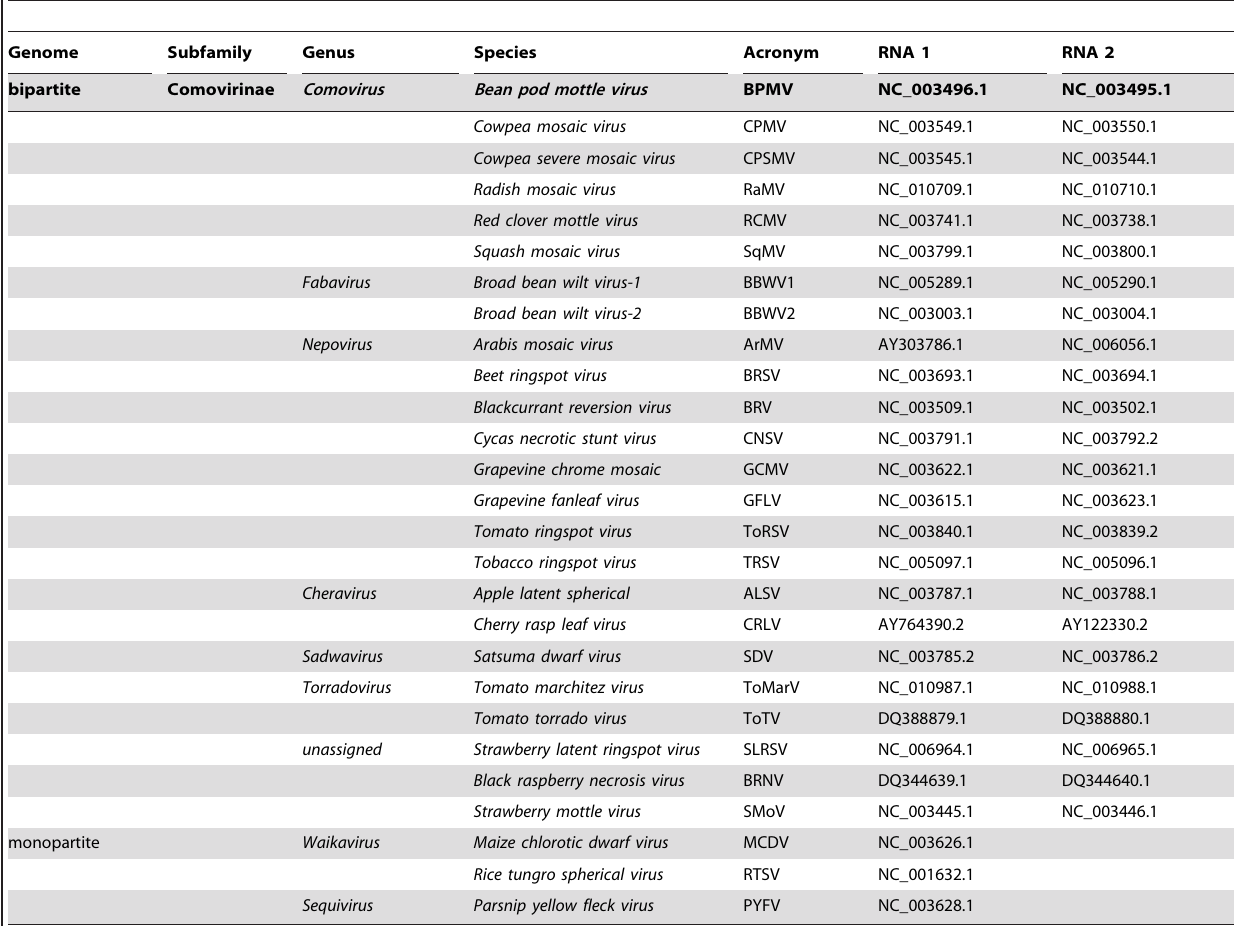
Table 1. List of Secoviridae isolates and related sequences used in the analyses, including their acronyms and Genbank accession